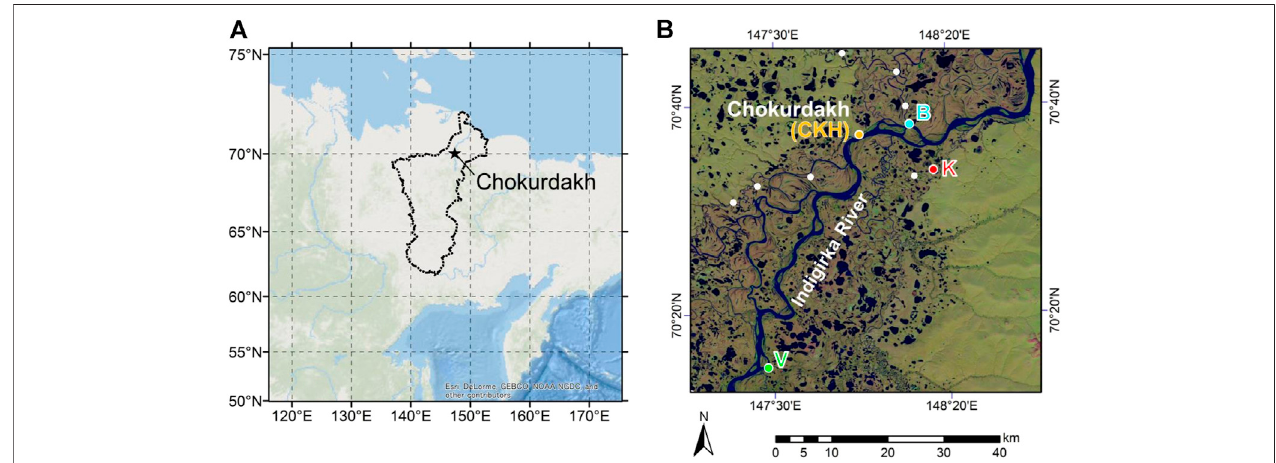
FIGURE1| Locationofthestudyarea. (A) LocationofthestudyregioninnortheasternSiberia(ArcGISESRI,Redland,CA,UnitedStates)modi fi edbyTakanoetal. (2019).TheIndigirkaRiverbasinboundariesareshownwithablackline. (B) SatelliteimageoftheIndigirkaRiverlowlandaroundthevillageofChokurdakhfromLandsat8 modi fi ed by Shingubara et al. (2019). Observation points of the mainstream (CKH, B, and V) and one tributary (K) of the Indigirka River are shown. Those of the other tributaries are shown by closed white circles.